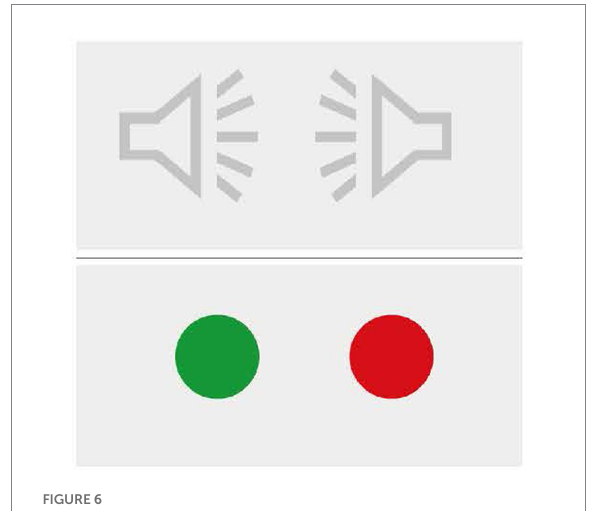
FIGURE 6 The graphics presented during the discrimination experiment. Upper panel: during playback. Lower panel: signal to